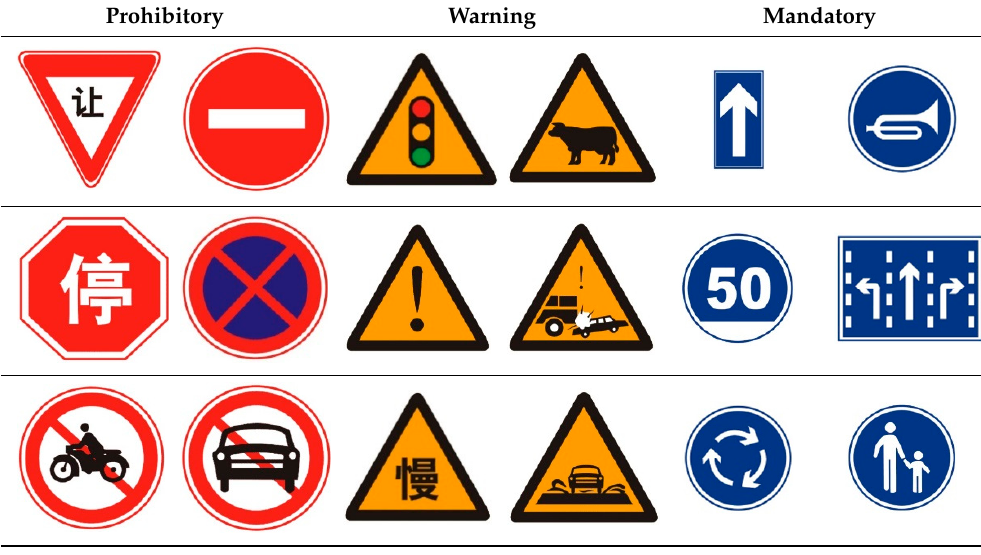
Table 2. Experimental environmental parameters.